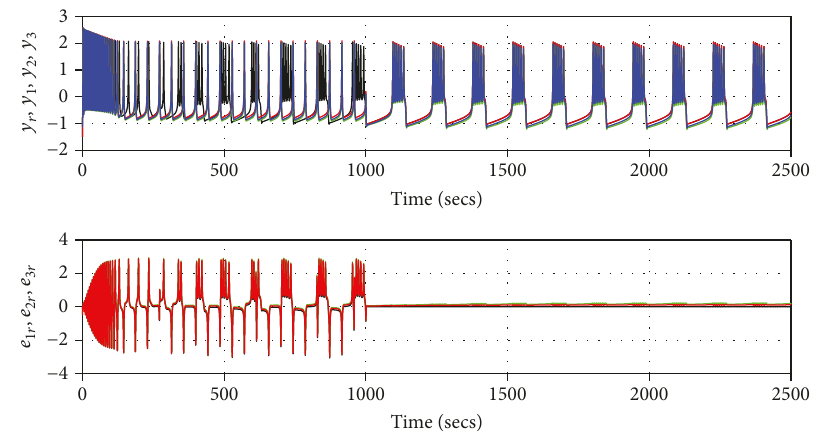
Figure 8: Outputs y